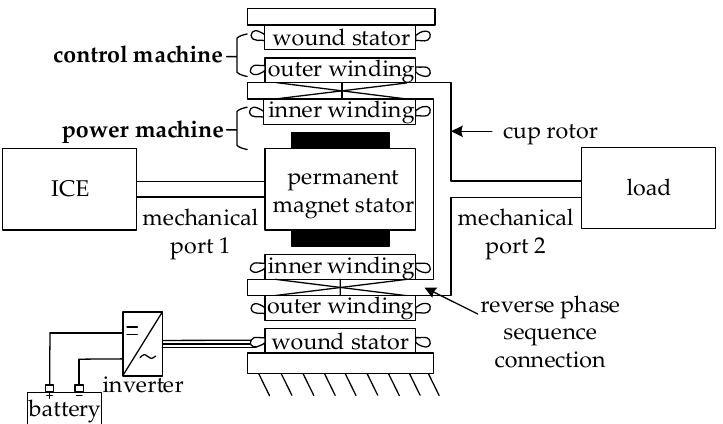
Figure 1. Structure diagram of cup rotor permanent-magnet doubly fed